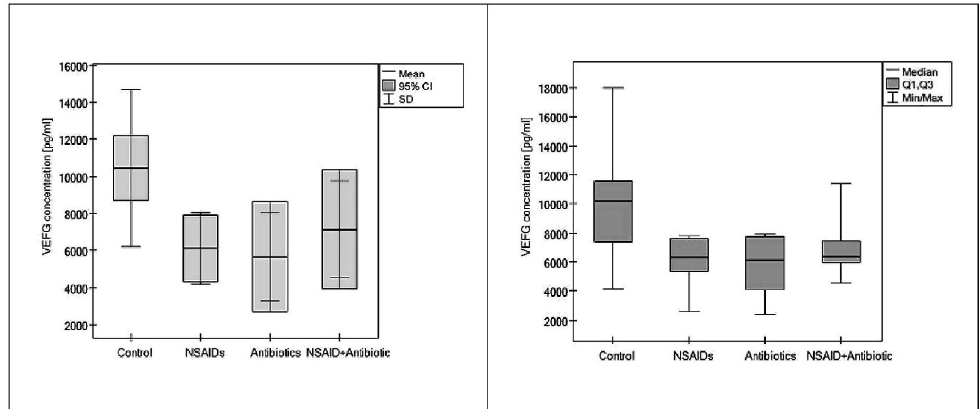
Figure 2. Example of electrophoretic separation of PCR products for VEGF-B, MWM-molecular weight marker (50–500 bp); 1–6-samples (84 bp); 7-positive control; 8-negative control.